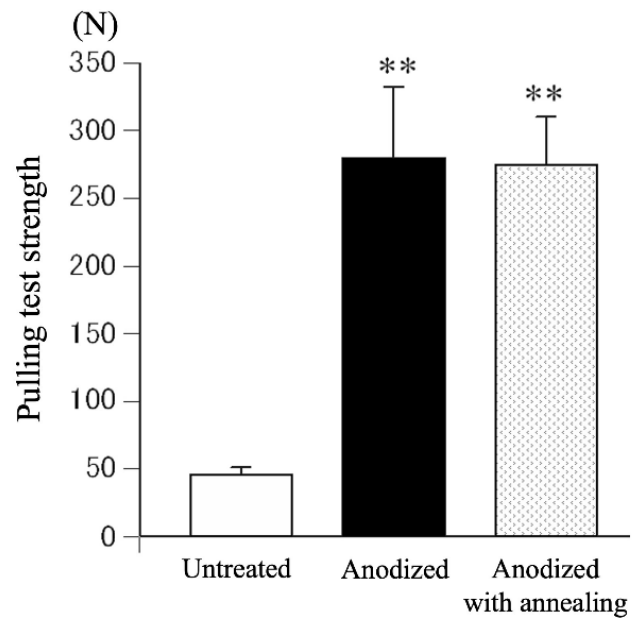
Figure 9. Comparison of pull-out strength of TiNbSn rods treated by sulfuric acid anodization, sulfuric acid anodization with annealing treatment, and untreated TiNbSn rods . The pull-out strength was assessed six weeks after TiNbSn rod implantation into rabbit femurs. **: p < 0.01 using one-way analysis of variance post hoc by Tukey Kramer test.